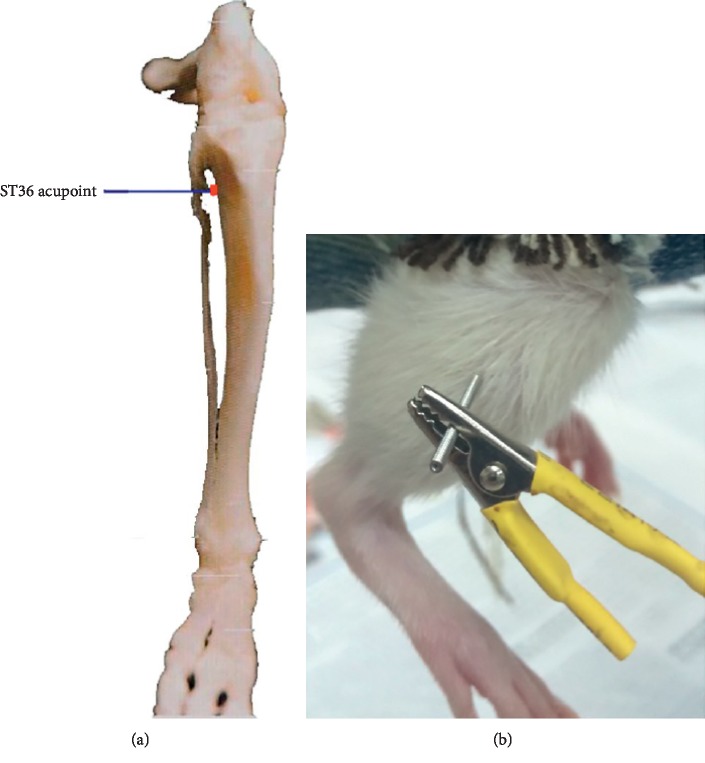
(a, b) The location of the ST36 acupoint on the SD rats [18].